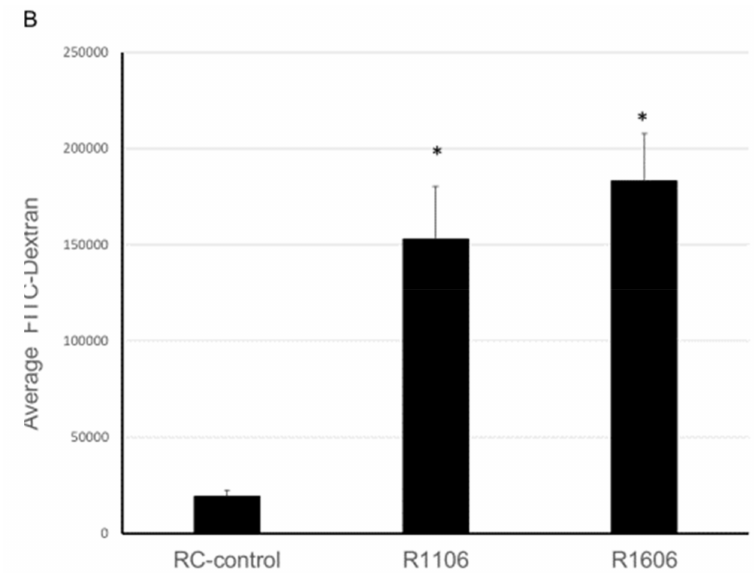
Figure 5. Down-regulation of REST increased vessel permeability. ( A ) Dextran-FITC vessel permeability assay and CD31 staining were performed in the different tumor samples from tumor-bearing mice (three groups of mice, 5 mice per group). CD31 expression indicates tumor vessels, and FITC-labeled dextran (green) indicates vascular leakage due to increased permeability. Scale bar: 50 µ m. ( B ) The averages of FITC-labeled dextran in the different tumor samples were quantified. Bars represent standard deviation. * p <